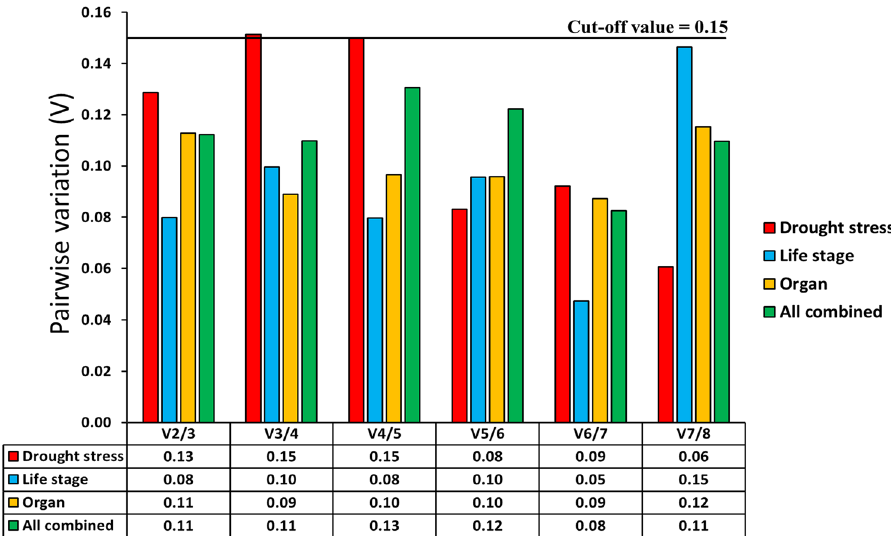
Figure 3. Pairwise variation to determine the optimal number of reference genes. The recommended cutoff value under which there is no need for another gene is